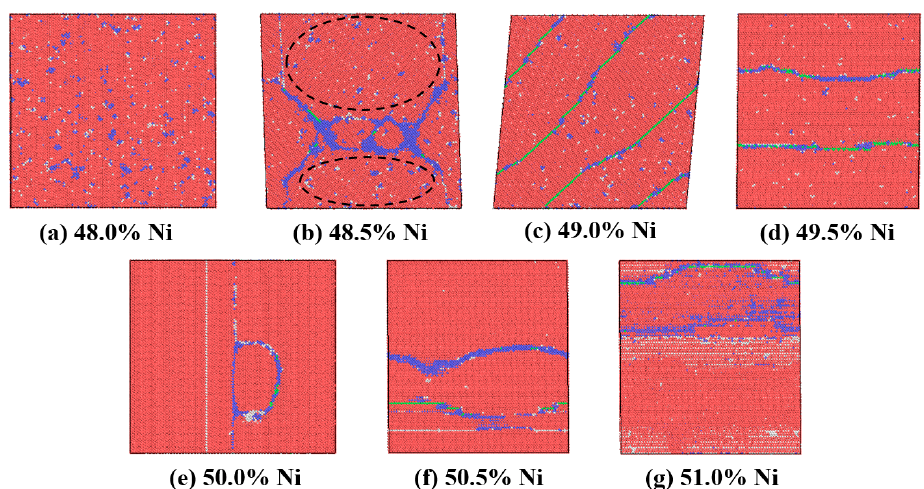
Figure 13. Microstructures with different Ni content ranging from 48.0% to 51.0% at a temperature of 50 K, where red, blue, green and white atoms represent the HCP, BCC, FCC and other structures, respectively.